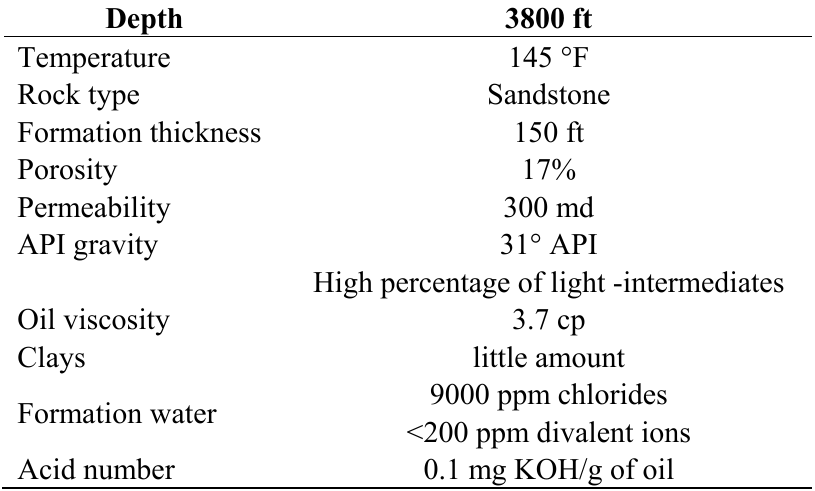
Table 1. Summary of reservoir and fluid